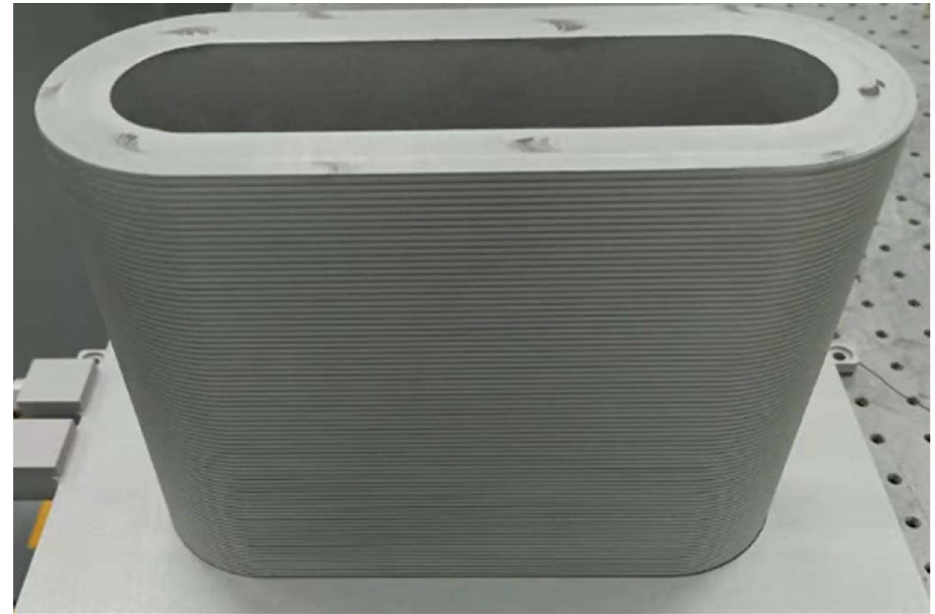
Figure 4. Picture of the oval-shaped aluminum cylinder acting as the heat sink.